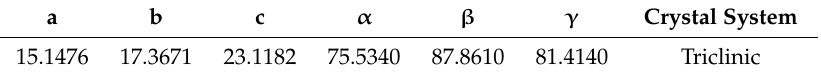
Table 1. Lattice constants of the ABMP cell measured by single crystal X-ray diffraction (SXRD).